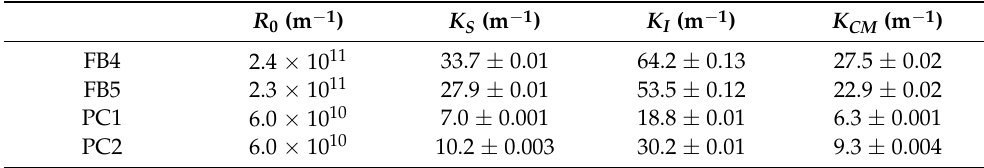
Figure 5. Characterization of blocking mechanism during constant flux direct (not pre-clarified) depth filtration of FB4 (Millistak ® + D0HC) by linear regression. Regression results of standard ( a ), interme- diate ( b ), and composite media models ( c ). Black squares represent the experimental pressure values. The membrane resistance is calculated from the initially present pressure difference via equation. This results in the parameters for the modeling shown in Table 1. Table 1. Resulting parameters for the modeling of the harvest via depth